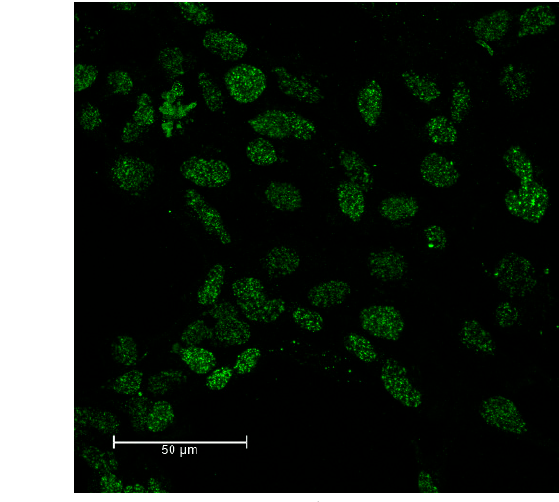
instance, across the depth of the cells ( a ) 9LGS control and ( b ) with 50 µ g/mL of AuNP solution, both